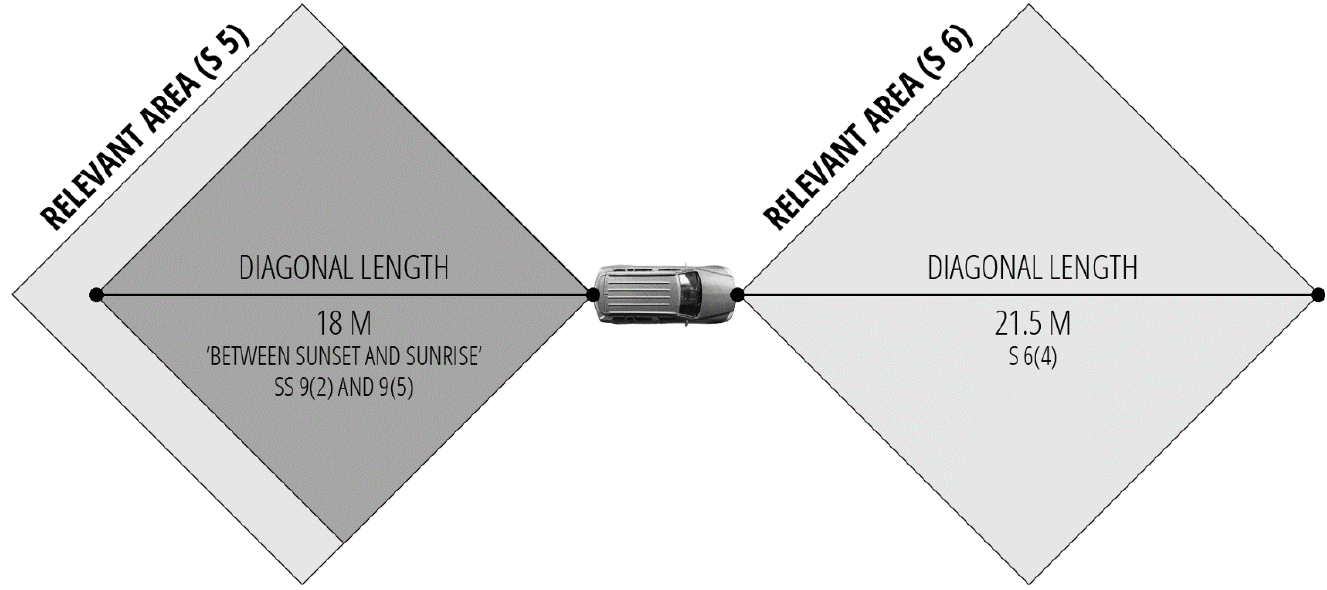
Figure 3. Diagram of the ‘Relevant Area’ as defined by Section 4 of the 2001